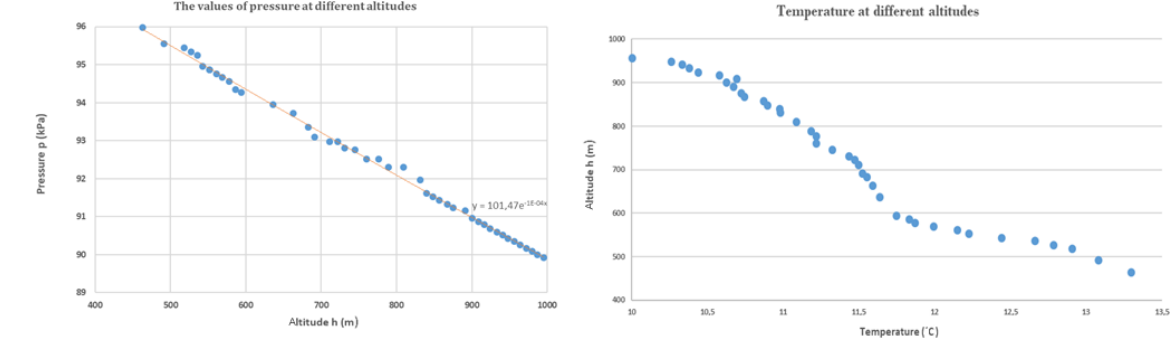
Figure 6. The air pressure and temperature measured by the flying unit at different